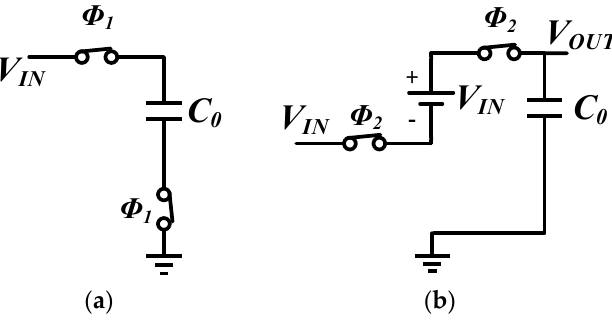
Figure 4. Equivalent circuit of Makowski charge pump: ( a ) during phase φ 1 ; ( b ) during phase φ 2 .